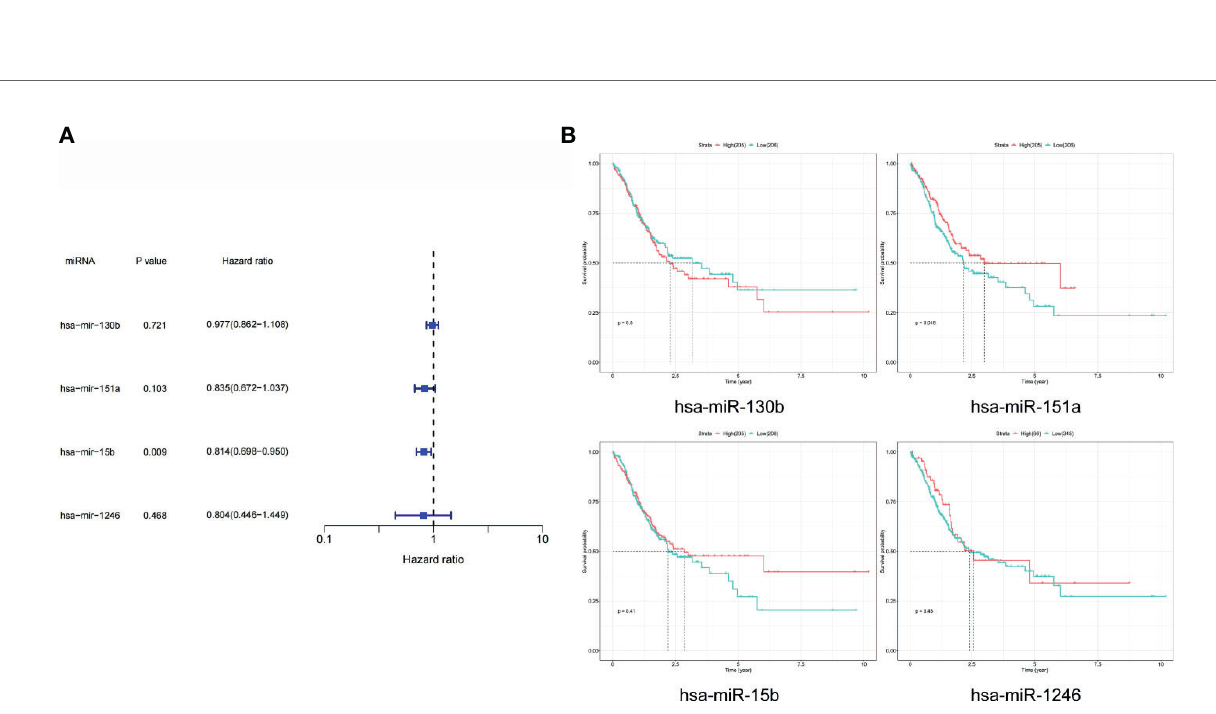
FIGURE 4 | Prognostic analysis of DEmiRNAs in TCGA. (A) The p value, risk coef fi cient HR and con fi dence interval of the DEmiRNAs. (B) Kaplan-Meier survival analysis of the DEmiRNAs signature.